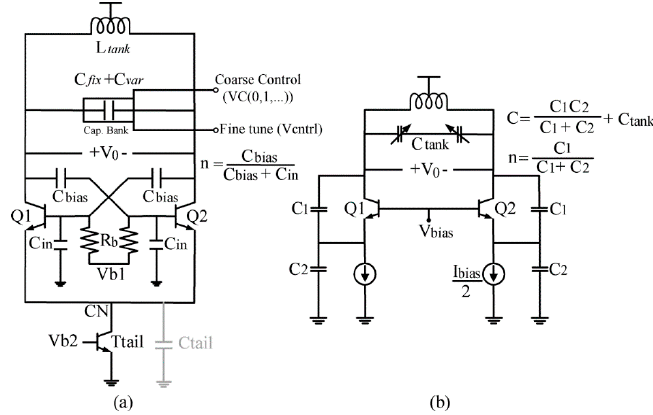
Figure 1. Standard schematics of ( a ) class-C and ( b ) differential Colpitts